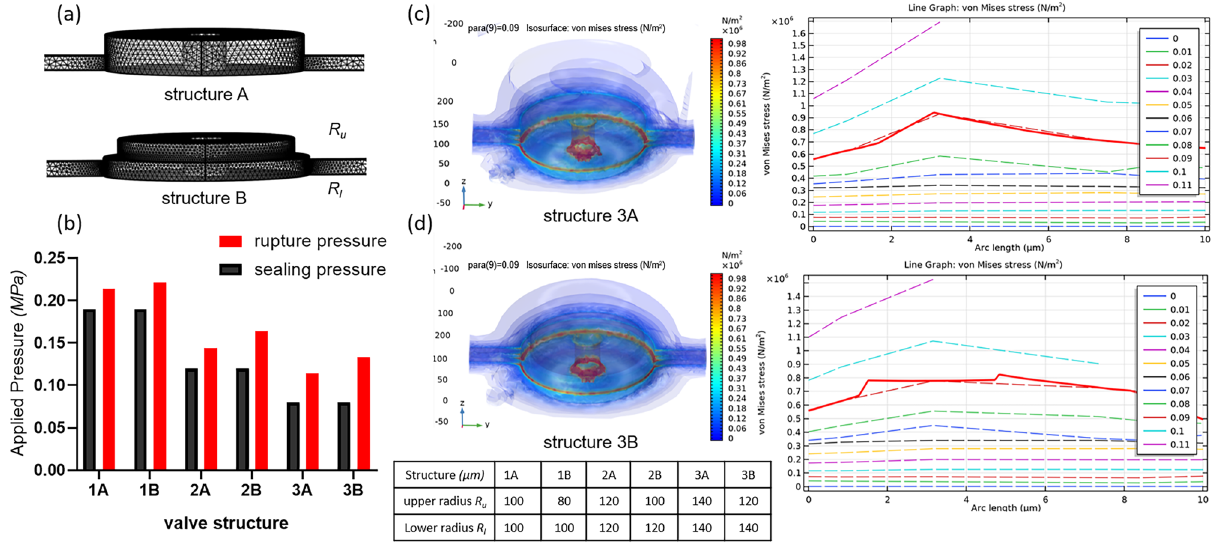
Figure 3. Effect of the valve structure on sealing pressure and rupture pressure/computation failure ( a ) mesh geometries of valve structures ( b ) comparison of the sealing and rupture pressures by valve structures ( c ) 3D modeling and line graph of the von Mises stress in structure 3A and ( d ) structure 3B. Figures were generated using COMSOL Multiphysics 5.5